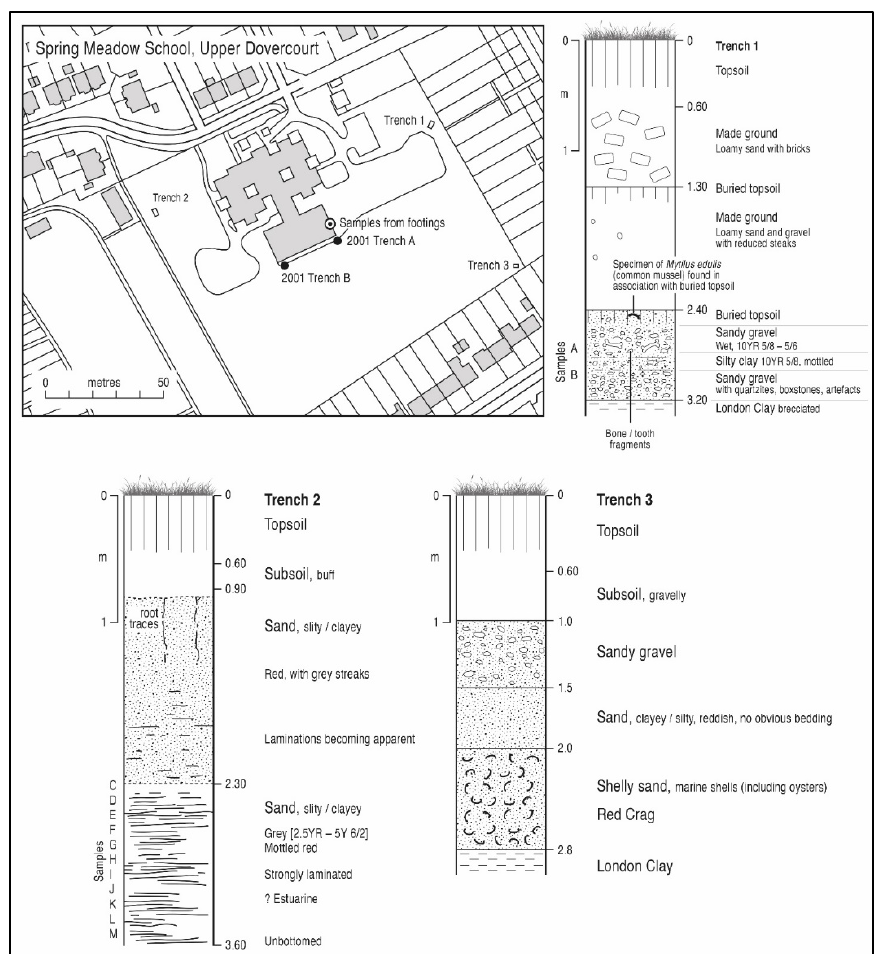
Figure 10. The 2006 investigation at Spring Meadow School, Upper Dovercourt, the site of the former Gant’s Pit (Peter Allen, David Bridgland, Danielle Schreve and Mark White). The location of the three depicted trenches, as well as those excavated in 2001 and the sampling point during the 1980s, are shown in the plan (top left). Bone fragments and artefacts were found in the sandy gravel below 2.4 m in Trench 1.